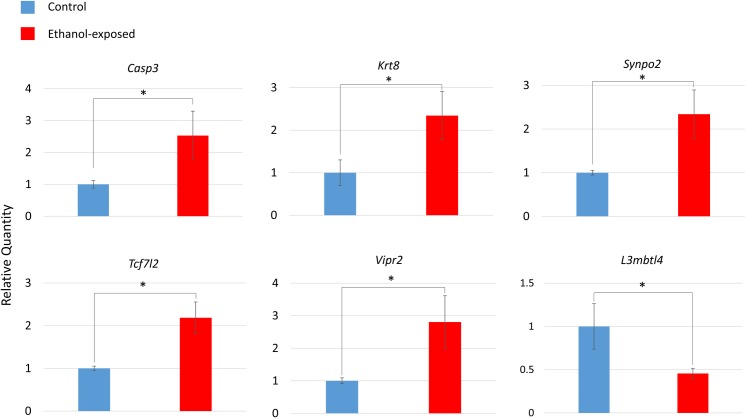
Droplet digital PCR (ddPCR) confirmation of differential gene expression.Data are normalized to a gene of interest relative quantity of 1.00 for the control group. n = 14, 7 ethanol-exposed and 7 control mice. Data are mean ± standard error. *p<0.05 (Student’s t-test).